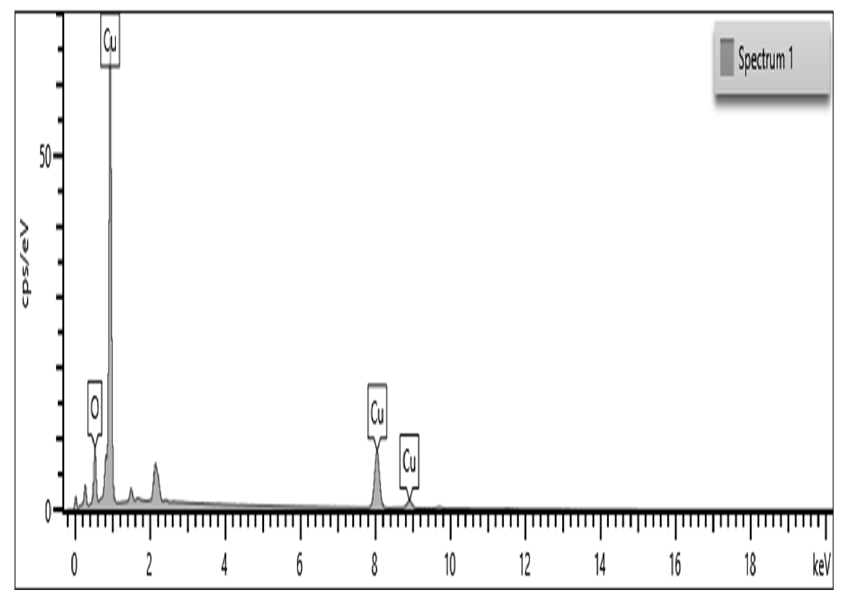
Figure 2. According to the EDaX image, the elementary composition evaluation ranges from 0 to 20 keV. Several elements are shown, and among the elements Cu (copper) is a major particle .